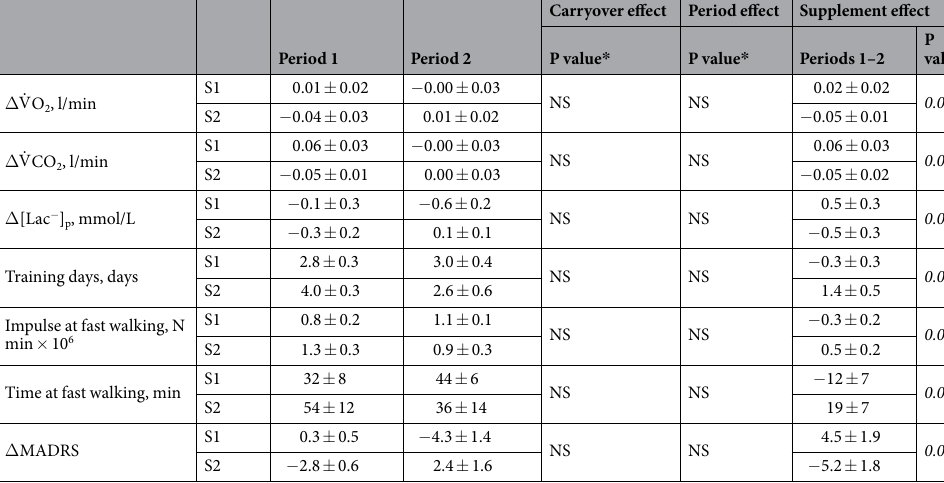
Table 3. Crossover